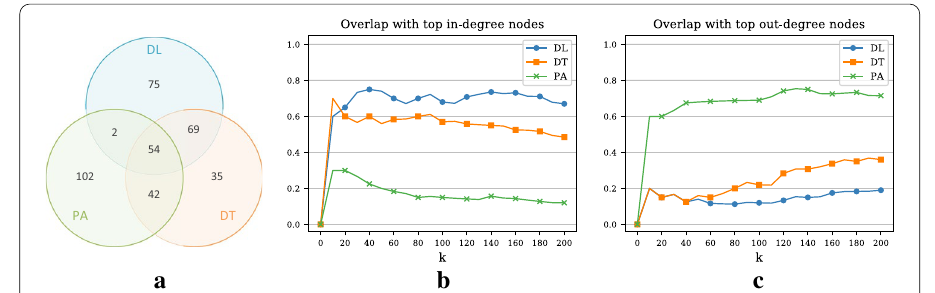
Fig. 8 Comparison of the three objectives and in- and out-degree heuristics (Example 2). a Venn diagram respresenting the overlap of the top 200 nodes for the three different objectives. b Overlap of the three objectives with the in-degree heuristic (measured as the size of the intersection divided by k ) for increasing k . c Overlap of the three objectives with the out-degree heuristic for increasing